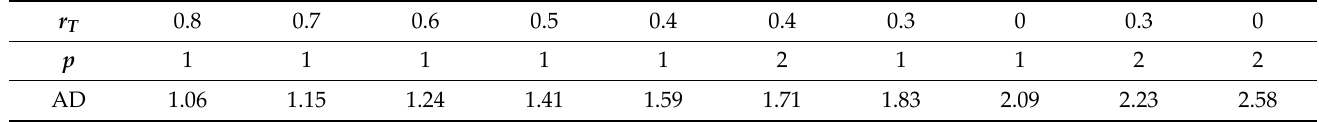
Table 7. The parameters of the quasi‑trapezoidal window function.